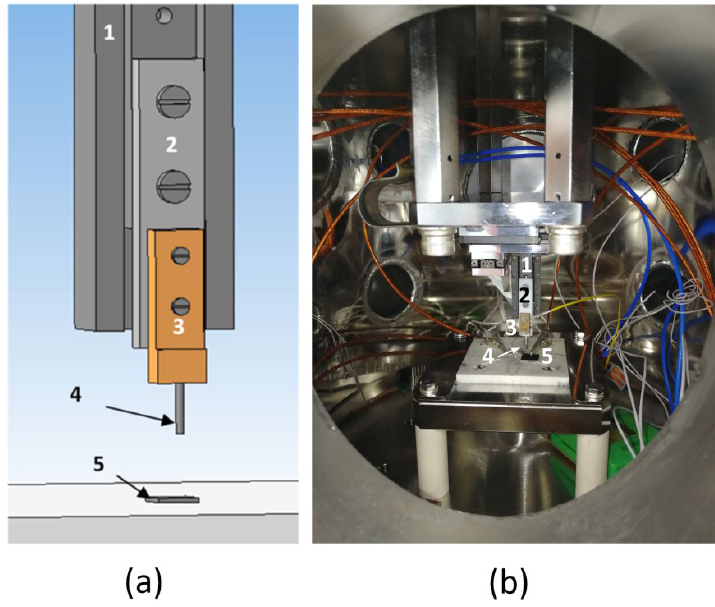
Figure 2. Experimental setup for measuring field emission, containing an anode positioning system relative to the sample in a vacuum chamber (1—SLC-17, 2—fluoroplastic plate, 3—contact plate, 4—anode, 5—sample): ( a ) Scheme and ( b ) External view.